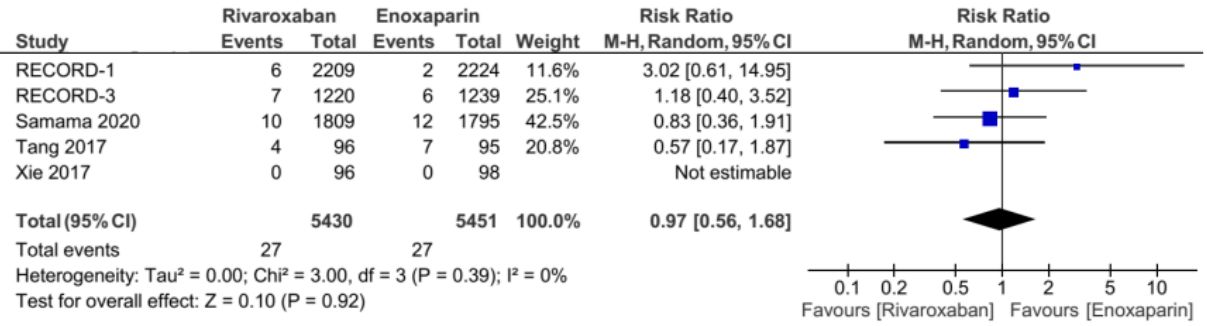
Figure 7. Incidence of any clinically relevant bleeding (major bleeding and any other clinically relevant bleeding) [5,7,12–14].